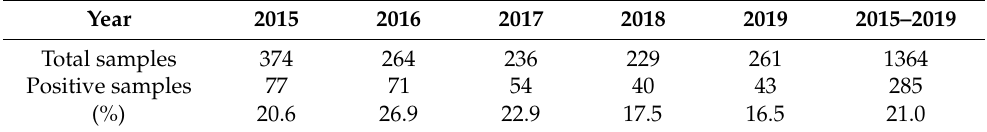
Table 1. Conjunctival sample distribution by year.